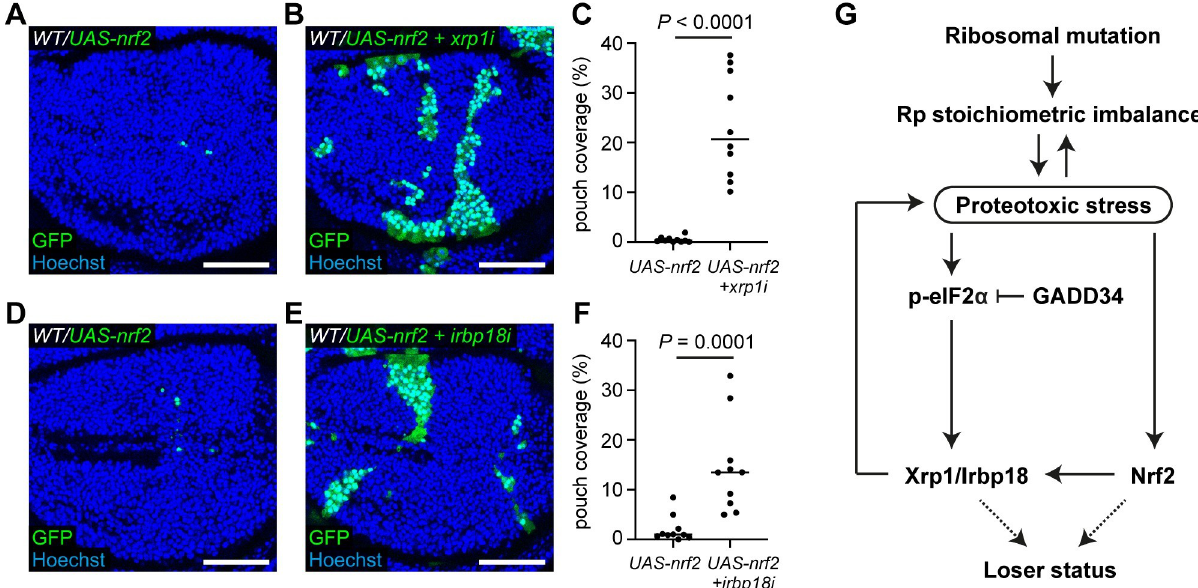
Fig 6. Xrp1 and Irbp18 function downstream of Nrf2. ( A-C ) Wild-type wing discs harboring UAS-nrf2 expressing cells (GFP positive) ( A ) or UAS- nrf2 and xrp1-RNAi ( xrp1i ) expressing cells (GFP positive) ( B ) with nuclei labelled in blue, and quantification of percentage coverage of the pouch ( C ) (n = 10 and 10, respectively; two-sided Mann–Whitney U-test). ( D-F ) Wild-type wing discs harboring UAS-nrf2 expressing cells (GFP positive) ( D ) or UAS-nrf2 and irbp18-RNAi ( irbp18i ) expressing cells (GFP positive) ( E ) with nuclei labelled in blue, and quantification of percentage coverage of the pouch ( F ) (n = 10 and 10, respectively; two-sided Mann–Whitney U-test). ( G ) Working model describing the role of the Xrp1/Irbp18 complex in Rp/+